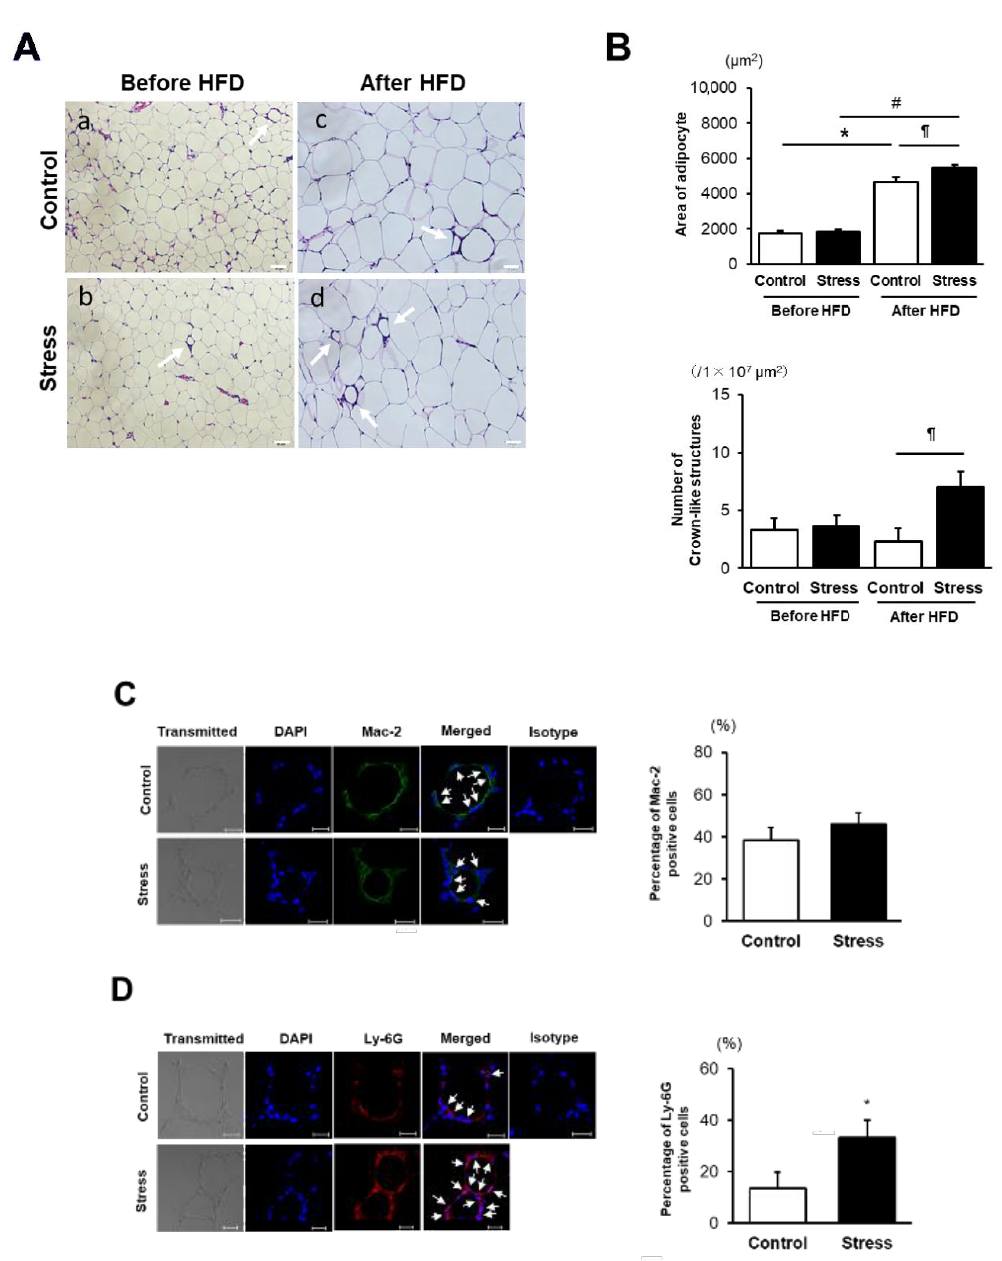
Figure 2. SS enhances neutrophil accumulation in epididymal white adipose tissue (eWAT). ( A ) Representative images of a hematoxylin and eosin-stained eWAT from control (a,c) and stressed (b,d) mice before and after 6 weeks of HFD, respectively. Arrow shows crown-like structures (CLSs). Scale bar = 50 μm. ( B ) Quantitative analysis of adipocyte size and the number of CLSs. Values represent the mean ± SEM for 10 (Control) and 10 (Stress) mice before HFD as well as 10 (Control) and 9 (Stress) mice after 6 weeks of HFD. * p < 0.01 vs. Control before HFD. # p < 0.01 vs. Stress before HFD. ¶ p < 0.05 vs. Control after HFD. ( C ) Immunohistochemical staining of Mac-2-positive cells and the percentages of Mac-2-positive cells in CLSs of eWAT. Values represent the mean ± SEM. Each group consisted of five (Control) and five (Stress) mice. Arrow indicates Mac-2-positive cells. Scale bar = 20 µm. ( D ) Immunohistochemical staining of Ly-6G-positive cells and the percentages of Ly-6G-positive cells in CLSs of eWAT. Values represent the mean ± SEM. Each group consisted of 9 (Control) and 10 (Stress) mice. * p < 0.05 vs. Control. Arrow indicates Ly-6G-positive cells. Scale bar = 20 µm. Control, unstressed control mice; Stress, stressed mice.